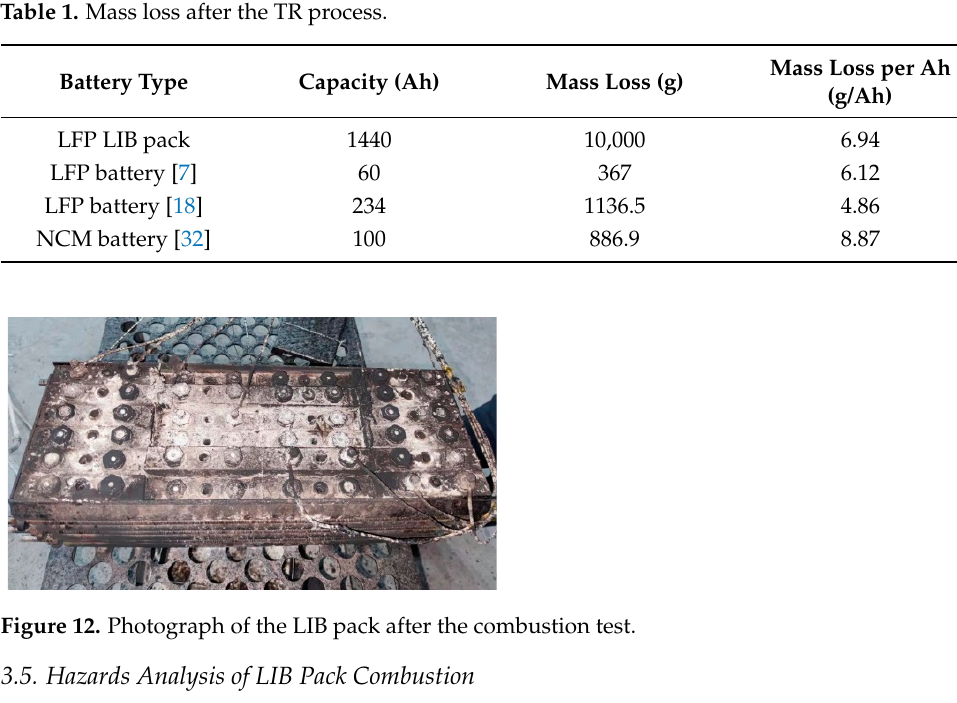
Figure 11. SPR and TSP during the LIB pack combustion process.